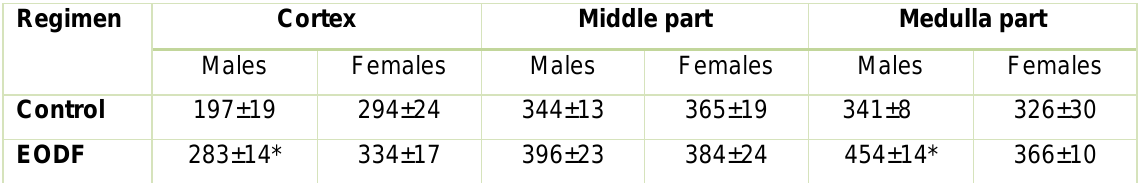
Table 2: The effect of every-other-day fasting (EODF) regimen on the total non-specific antioxidant capacities (nmol Trolox equivalents/mg protein) in different parts of the brain of young mice